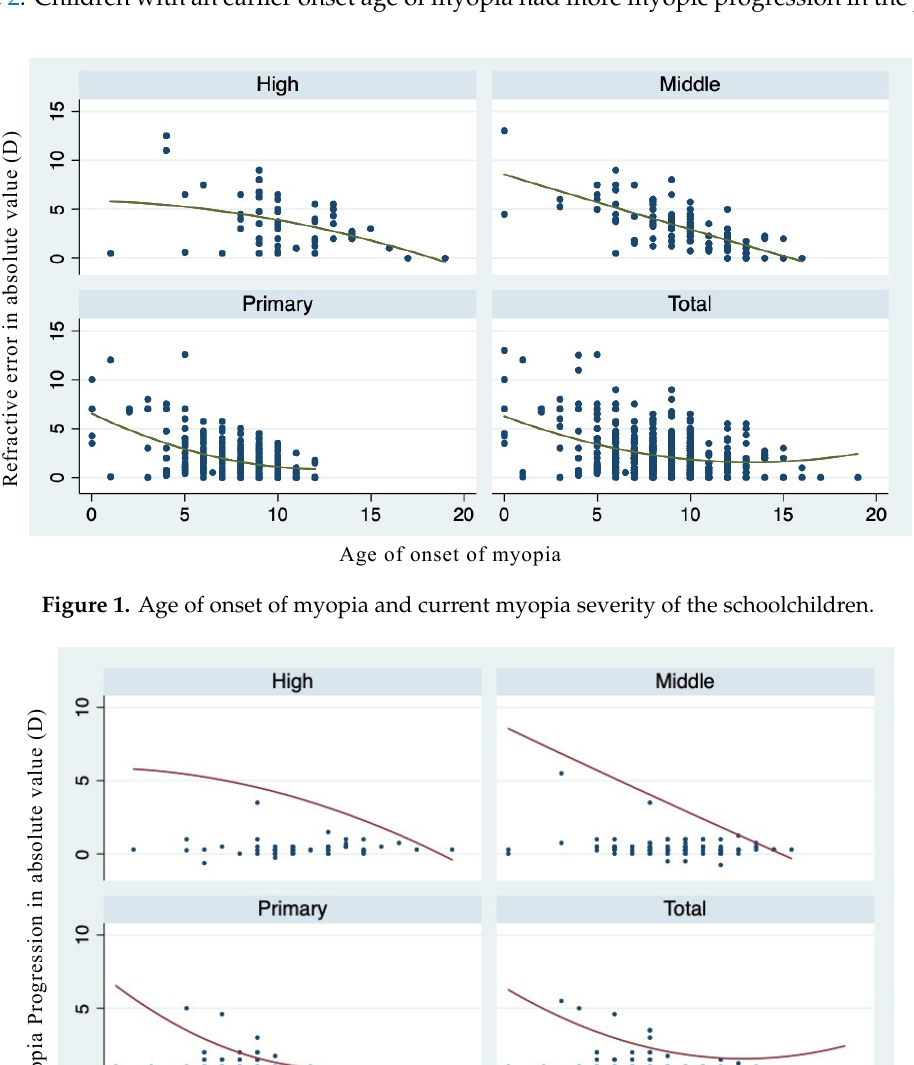
Figure 2. Age of onset of myopia and the myopia progress in the past year.